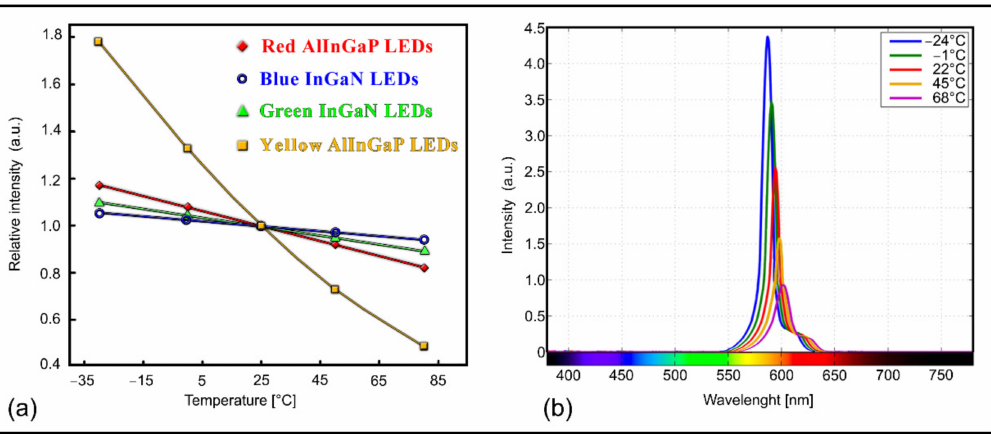
Figure 4. ( a ) Output power of blue/green InGaN and yellow/red AlInGaP LEDs as a function of temperature. The output power of each LED was normalized to 1.0 at 25 ◦ C. ( b ) Variations of the wavelength and intensity vs. temperature of a typical AlInGaP LED.